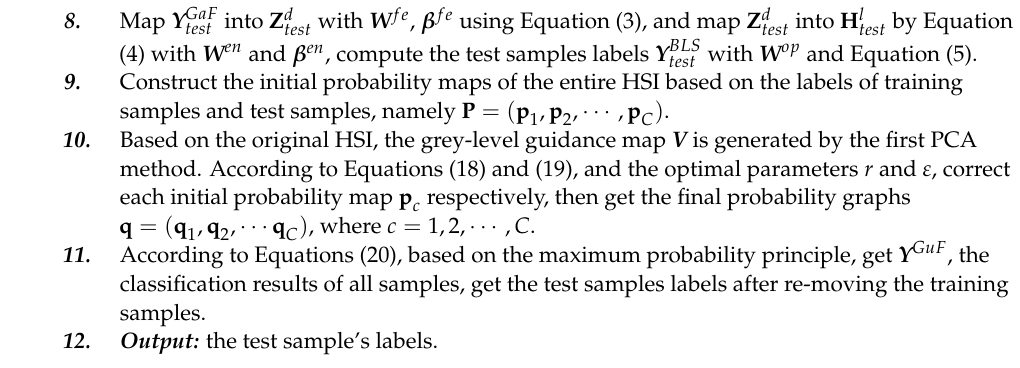
Figure 3. Salinas dataset with ( a ) original hyperspectral image, ( b ) ground truth, and ( c ) category names with labeled samples. The Pavia University dataset was collected by the Reflective Optics System Imaging Spectrometer (ROSIS) sensor over Pavia in northern Italy. The image has 610 × 340 pixels with 103 bands. Some pixels containing nothing in the image were removed. There were nine different sample categories used in our experiments. Figure 4 is the original hyper- spectral image, category names with labeled samples, and ground truth.